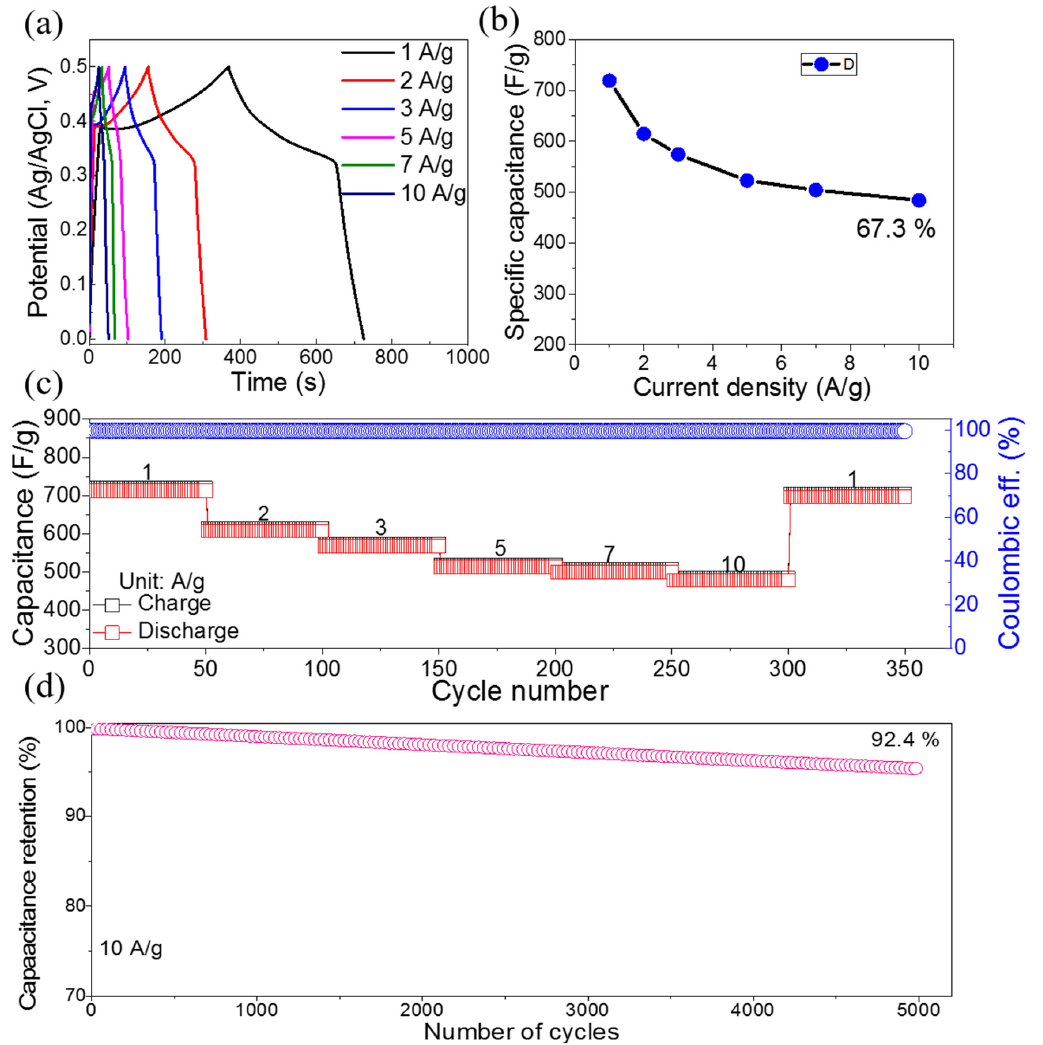
Figure 4. ( a ) GCD profiles of Ni-NPs; ( b ) specific capacitance vs. current density; ( c ) rate performance (left side) and Coulombic efficiency (right side); ( d ) cycling stability.